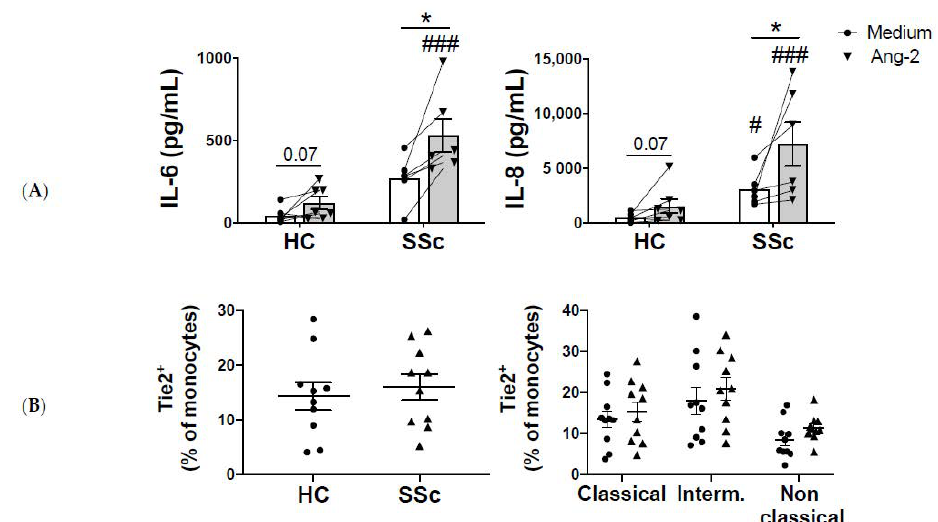
Figure 3. Ang-2 induces Interleukin (IL)-6 and IL-8 production in monocytes of SSc patients. ( A ) IL-6 and IL-8 production in HC and SSc monocytes ( n = 8 each) after 24-h incubation in medium or Ang-2 (200 ng/mL). ( B ) Percentage of Tie2 + expressing monocytes and monocyte subsets in HC and SSc patients’ monocytes ( n = 10 each). Means and SEM are shown. * p < 0.05, # p < 0.05 and ### p < 0.001 compared to medium.